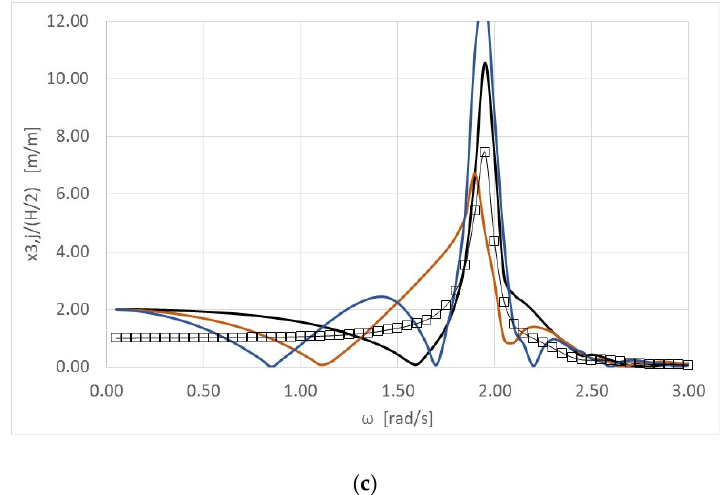
Figure 6. Dimensionless heave displacement of the 3rd WEC, j = 3, of the rectangular to the wall array, against ω , for three different examined distances from the vertical wall and three wave heading angles. Comparisons are made for the heave displacements of the same converter of the array without the presence of the breakwater: ( a ) θ = 0°; ( b ) θ = 45°; ( c ) θ = 60°.